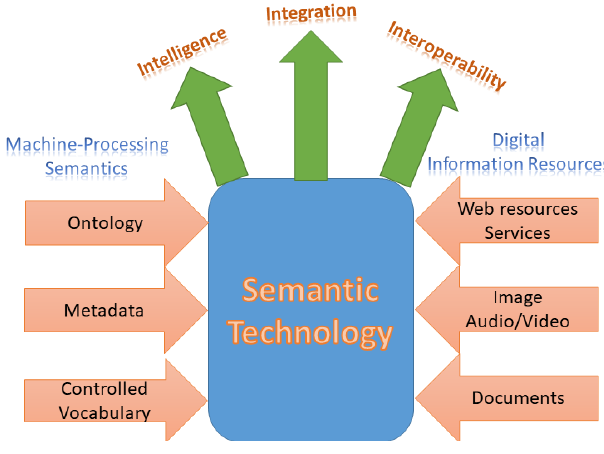
Figure 2. Semantic